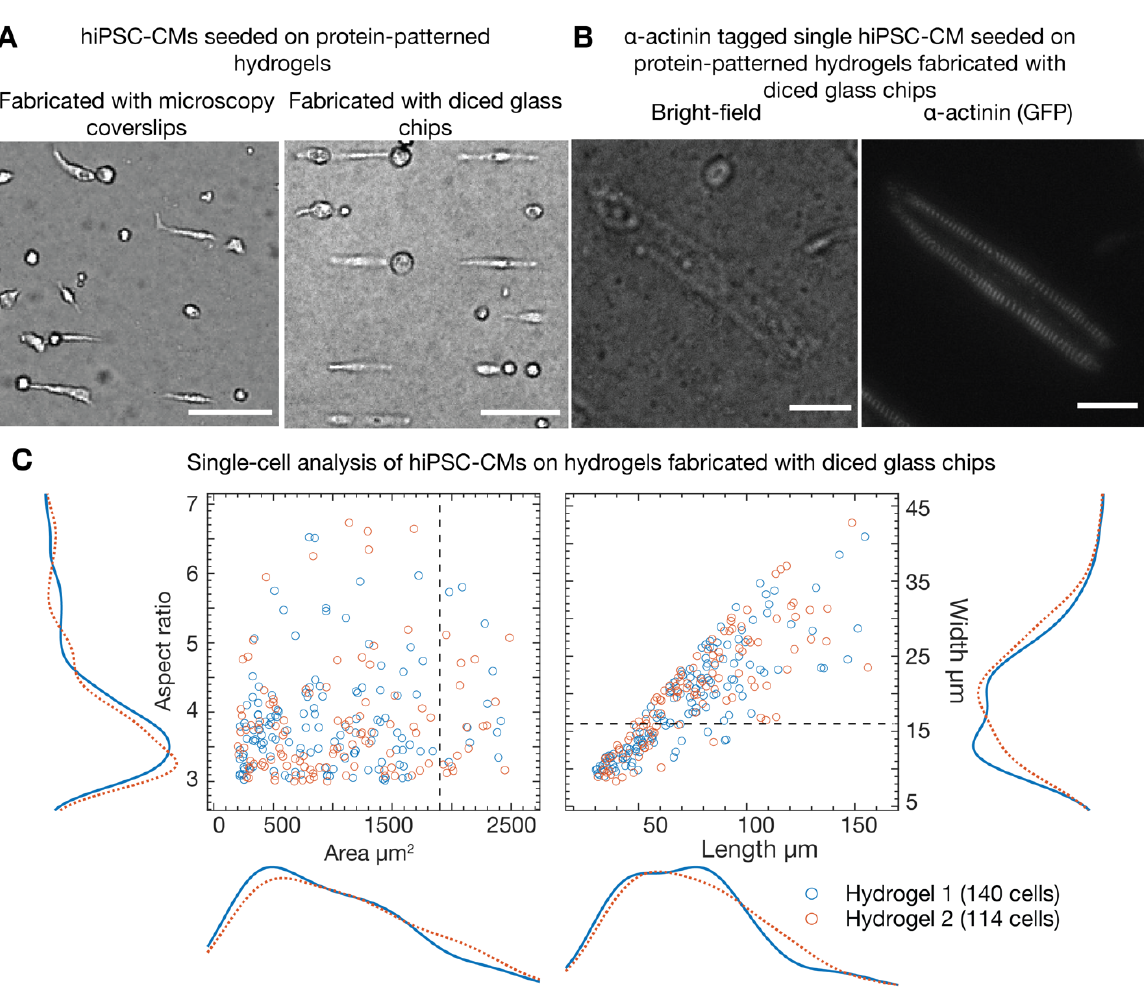
Figure 4. Human-induced pluripotent stem cell-derived cardiomyocytes (hiPSC-CMs) seeded on protein-patterned (Matrigel) hydrogels. ( A ) Comparison between cells seeded on hydrogels with protein transferred from microscopy coverslips fabricated in a serial process using the method described in [30] and from diced glass chips fabricated in a batch wafer-scale process as described in this paper. Scale bars denote 100 µm. ( B , C ) Analysis of cells on protein-patterned hydrogels fabricated from diced glass chips. ( B ) Microscopy images of an alpha-actinin labeled hiPSC-CM seeded on a hydrogel with protein transferred from a diced glass chip. Scale bars denote 25 µm. ( C ) Two-dimensional scatter plots of the aspect ratio and area and length and width, along with the marginal distributions of the parameters. The results are grouped by hydrogel with debris (objects with area below 200 µm 2 ) filtered out and high aspect ratio cells selected (between 3:1 and 9:1). The criteria for cells that extend well beyond the protein patterns (width above 16 µm) and likely cell doublets (area above 1900 µm 2 ) are indicated by the dashed lines. Cells were fixed for the analysis.